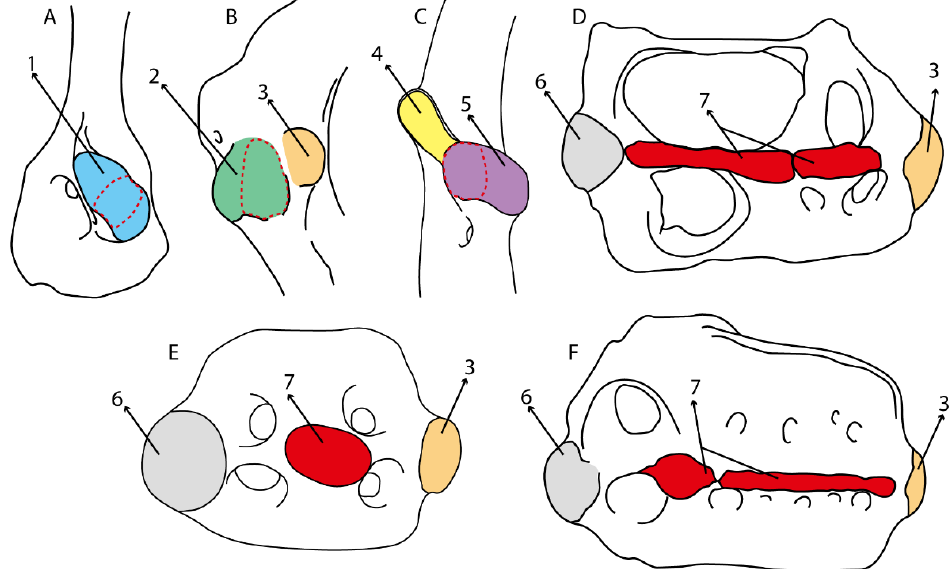
Figure 37. Interpretative drawings of scapulacoracoid in lateral view. State (0): ( A ) Heterodontus francisci (MZUSP 112022) redrawn and modified from da Silva and de Carvalho 8; Text-Figure 1A in [8]. State (1): ( B ) Squatina guggenheim (MZUSP 110871) redrawn and modified from da Silva and de Carvalho Text-Figure 12C in [8]. State (2): ( C ) Chlamydoselachus anguineus (MZUSP 110974) redrawn and modified from da Silva and de Carvalho Text-Figure 26A in [8]. State (3): ( D ) Gymnura japonica (HUMZ 48301) redrawn and modified from Nishida Text-Figure 31A in [82]; ( E ) Rhinobatos horkelii (MZUSP uncatalogued) redrawn and modified from da Silva and de Carvalho Text-Figure 18A in [8]; ( F ) Zapteryx brevirostris (UERJ-PMB 35). Annotations: (1) Single condyle (blue); (2) pro + mesocondyle (green); (3) metacondyle (orange); (4) facet for propterygium (yellow); (5) meso + metacondyle (purple); (6) procondyle (gray); (7) mesocondyle (red). 103. Mesocondyle: (0) Single and small; (1) segmented and small; (2) forming an elon-